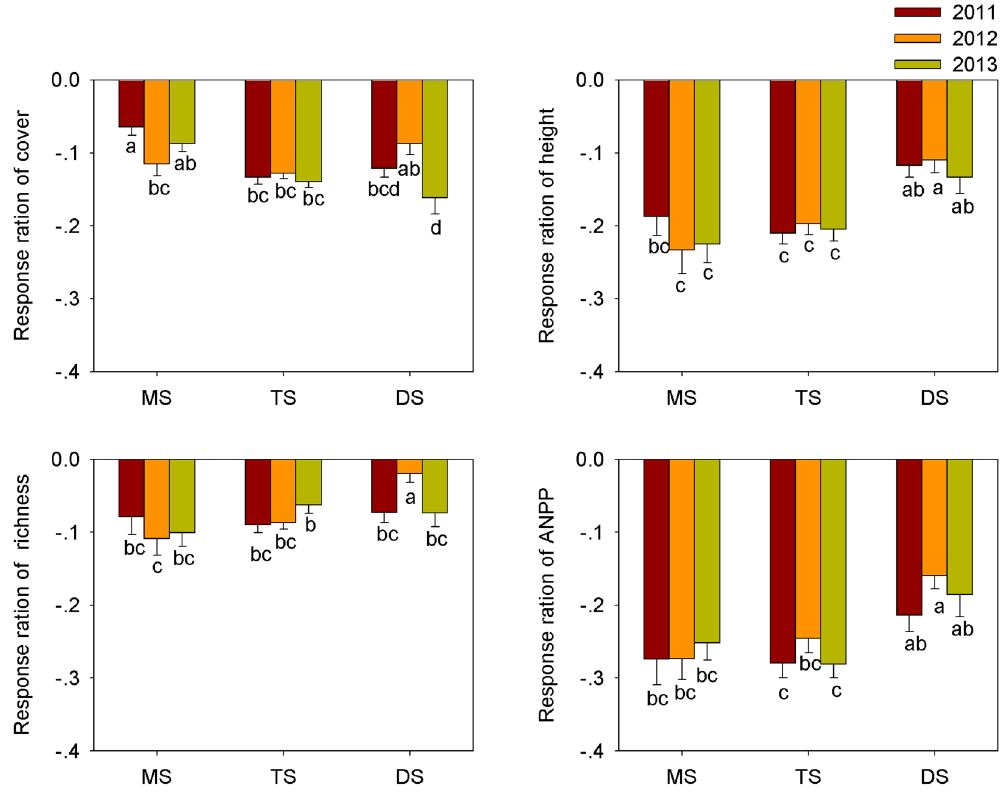
Figure 3. Spatial pattern of grazing-induced response in vegetation cover, height, species richness and AGB among three vegetation types (MS: meadow steppe; TS: typical steppe; DS: desert steppe) in